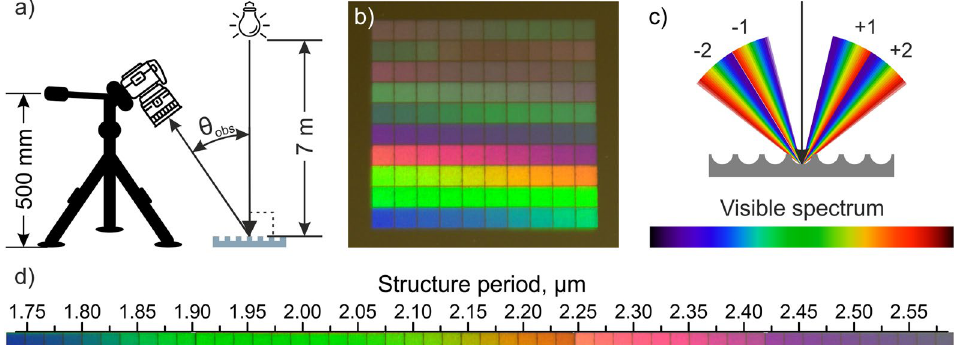
Figure 5. ( a ) Schematic representation of the used sample and observer (camera) positions; ( b ) photograph of a treated stainless steel sample with spatial periods ranging from 1.75 µ m to 4.59 µ m (size of each square is 1.5 mm); ( c ) schematic representation of diffracted withe light for the first and second diffraction orders; ( d ) optical micrograph of the observed structural colours depending on the spatial period for an observation angle of